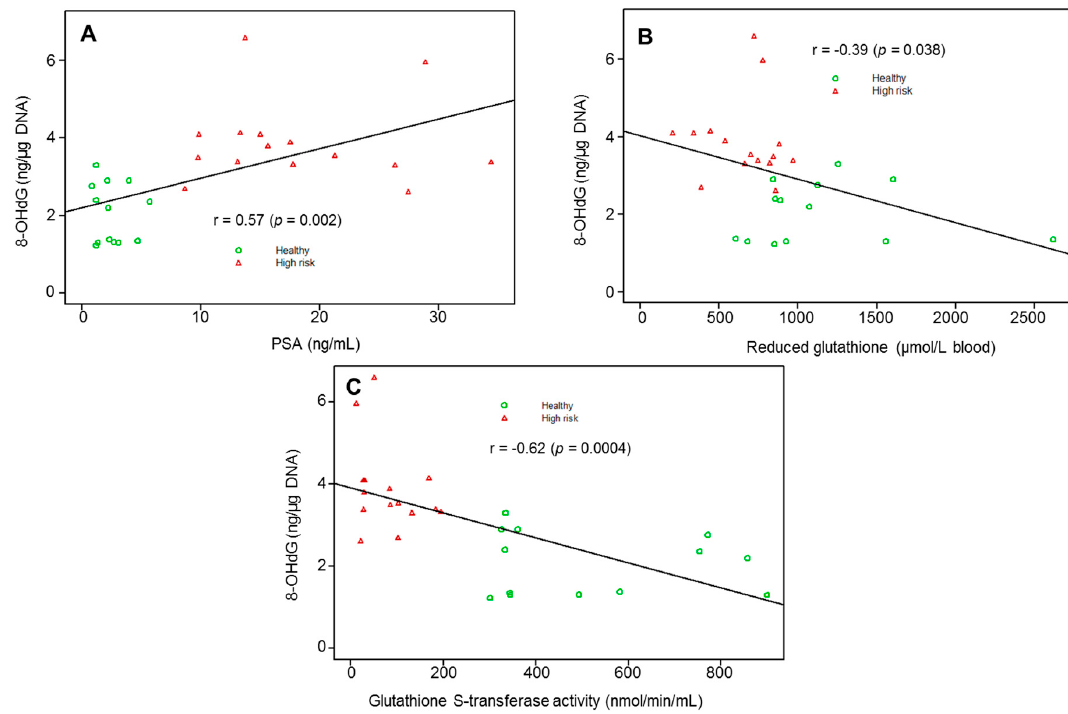
Figure 4. Correlation between ( A ) 8-OHdG versus serum PSA, ( B ) 8-OHdG versus erythrocyte reduced glutathione (GSH), and ( C ) 8-OHdG versus glutathione S-transferase activity in healthy controls and high-risk subjects for prostate cancer. The association was estimated using the Pearson correlation coefficient (r) and illustrated using a scatter plot. p -value < 0.05 is considered significant. In addition, a negative association between GSH-Px and CAT activity (r= − 0.33 ( p = 0.04)) and GST and PSA (r = − 0.69 ( p < 0.0001)) was noted between the groups (Figure 5A–B).